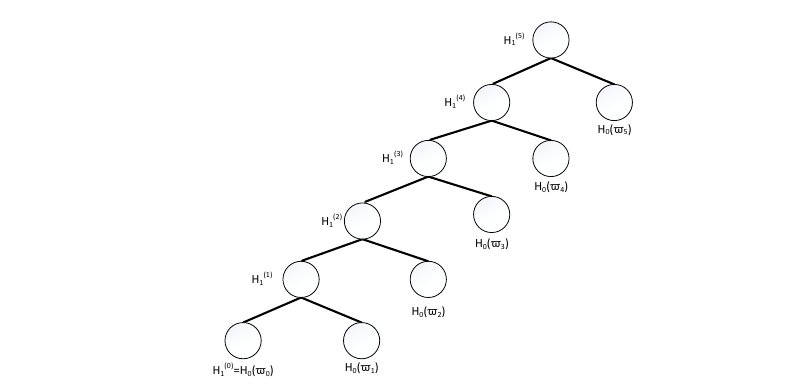
Figure 1. The Schematic of the Binary